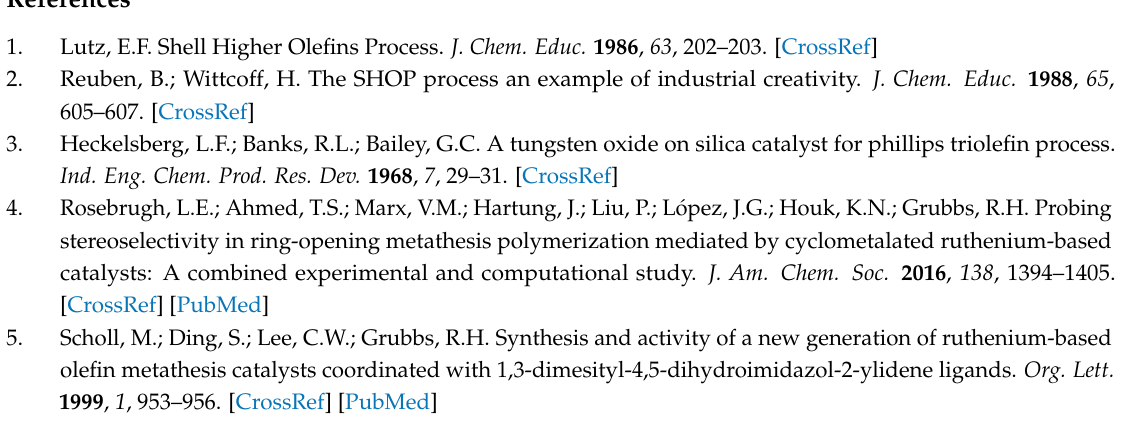
Table S1: 3D view, xyz coordinate data sets and absolute energies (a.u.) for the DFT optimized molecular systems, Table S2: Computed stationary points (energies in kcal/mol) for the olefin metathesis reaction pathway for M(SIMes)Cl 2 (=CHPh)PPh 3 (M = Fe and Co) with ethylene as a substrate ( m = multiplicity; 1 = singlet, 2 = doublet, 3 = triplet, 4 = quadruplet, 5 = quintuplet, 6 = sextuplet; g = gas and s = solvent); Table S3: Computed stationary points (energies in kcal/mol) for the olefin metathesis reaction pathway for M(SIMes)Cl 2 (=CHPh)PPh 3 (M = Ru and Rh) with ethylene as a substrate ( m = multiplicity; 1 = singlet, 2 = doublet; g = gas and s = solvent). Acknowledgments: A.P. thanks the Spanish MINECO for a project CTQ2014-59832-JIN and Xarxa de Qu í mica Te ò rica i Computacional for a VALCHEM2016